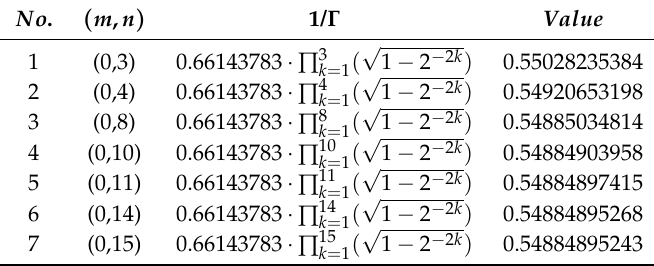
Table 5. The Parameter Value 1/ Γ in S